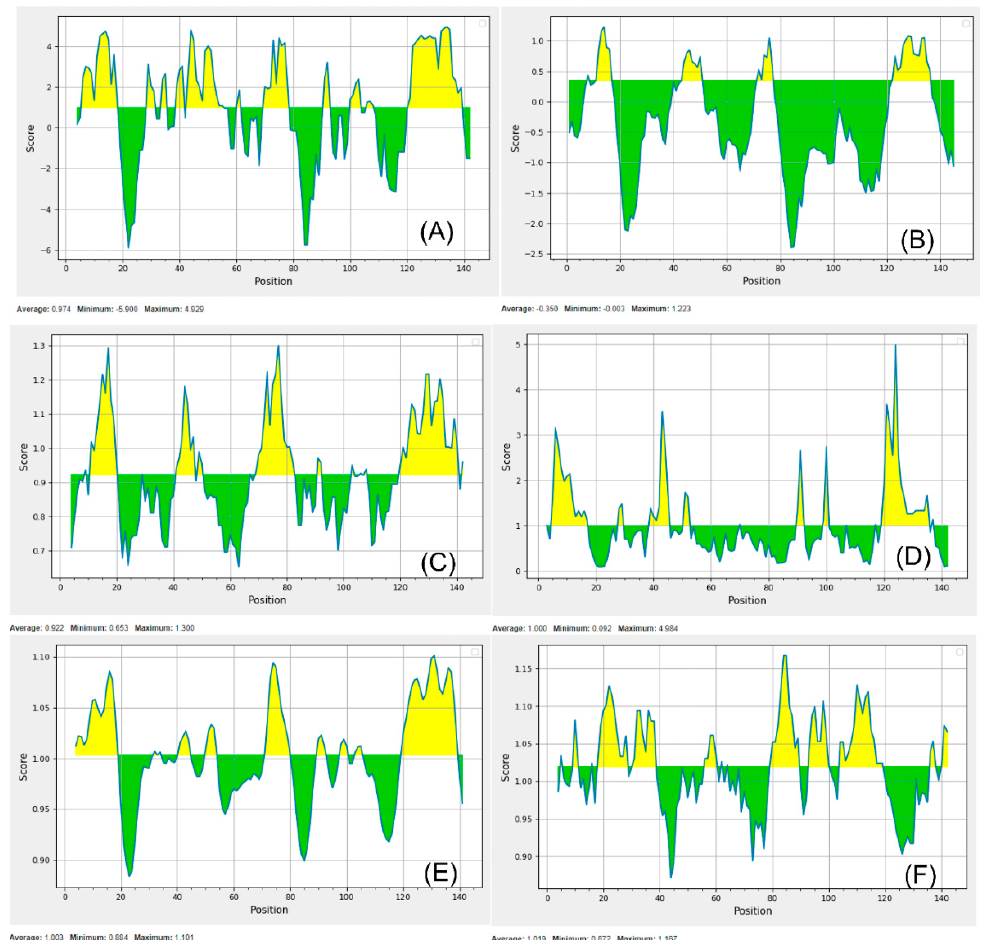
Figure 4. B-cell epitope in the FLiS protein based on Parker hydrophilicity prediction ( A ). Bepipred linear epitope ( B ). Chou and Fasman β -turn prediction ( C ). Emini surface accessibility prediction ( D ). Karplus and Schulz flexibility prediction ( E ). Kolaskar and Tongaonkar antigenicity ( F ). The x axis and y axis represent the sequence position and corresponding antigenic properties score, respectively. The threshold level was set as a default parameter of the server. The regions shown in yellow color above the threshold value were predicted as the B-cell epitope.